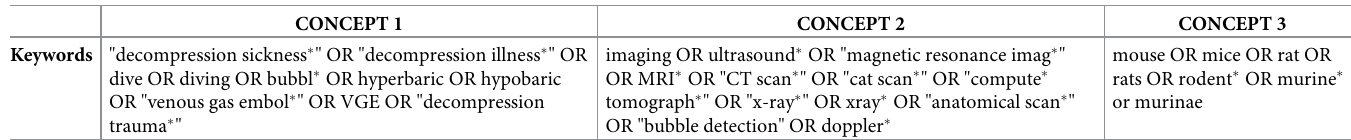
Table 2. Search term